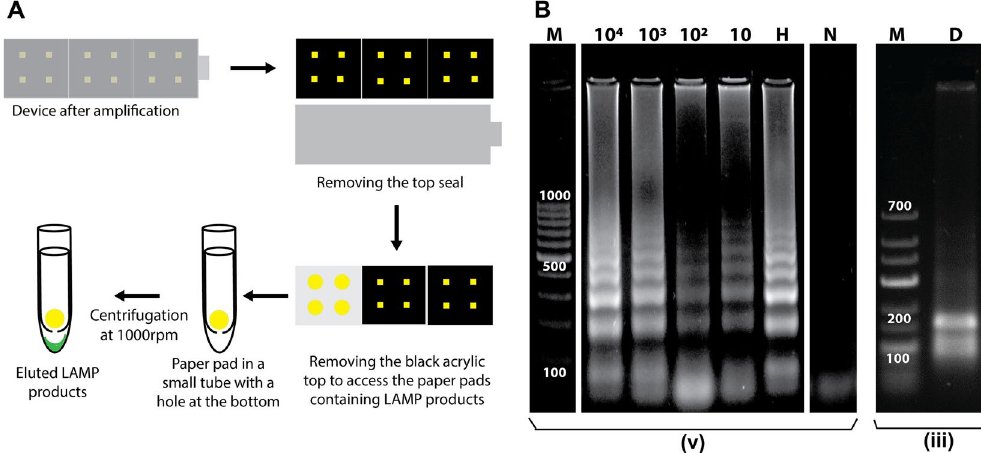
Figure 4. LAMP amplification in paper. ( A ) Schematic of the method used for retrieving the LAMP amplicons from the paper pads. ( B ) Gel electrophoresis analysis of products of LAMP reactions conducted in paper starting from varying number of starting Mtb gDNA copies (10 4 up to 10). The numbers on top of the wells indicate the starting copy number of the template. H- 1000 copies of human gDNA were added to the reaction mix along with 1000 copies of Mtb gDNA; N- No template control; M- DNA marker; and D- digested LAMP amplicons. The reaction time was 40 minutes. Larger spaces between sections of lanes in a gel image indicate lanes from different gels and smaller spaces represent lanes from the same gel. Full-length gels are presented in Supplementary Fig. S9 (iii) and